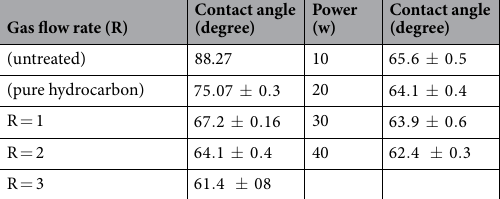
Contact angle (degree)